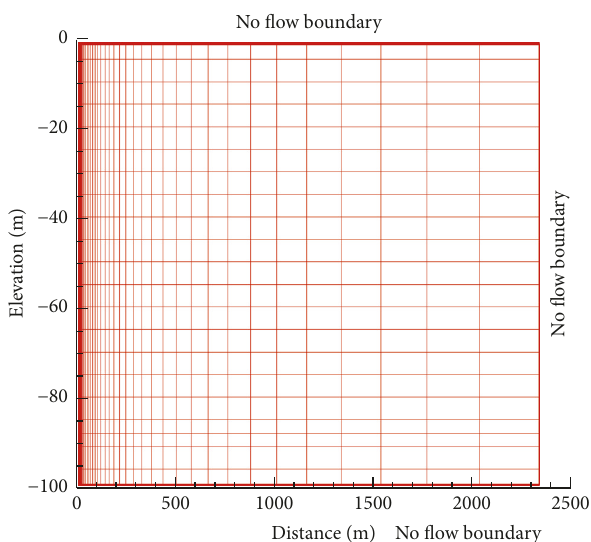
Figure 5: Reservoir meshing diagram (the upper and lower borders and right borders are